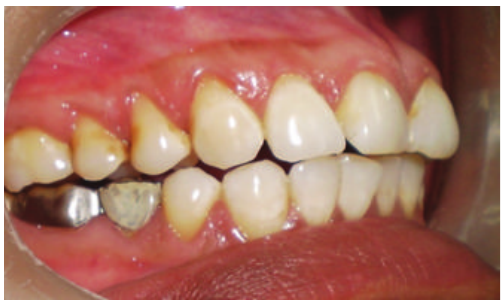
Figure 1: Facial view of gingival recession on 1st premolar and canine. The patient complained of root sensitivity in addition to the unaesthetic appearance when